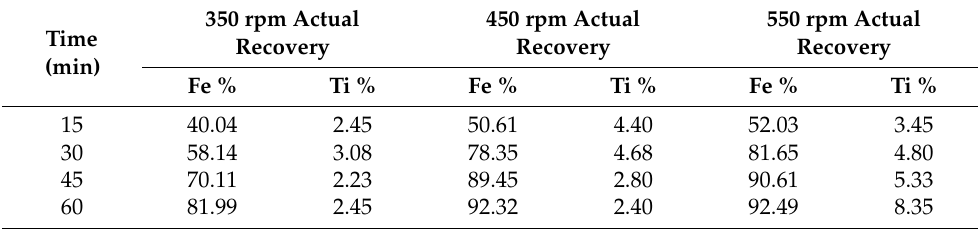
Table 4. Chemical analysis of the ilmenite ore with various sizes (350, 450 and 550